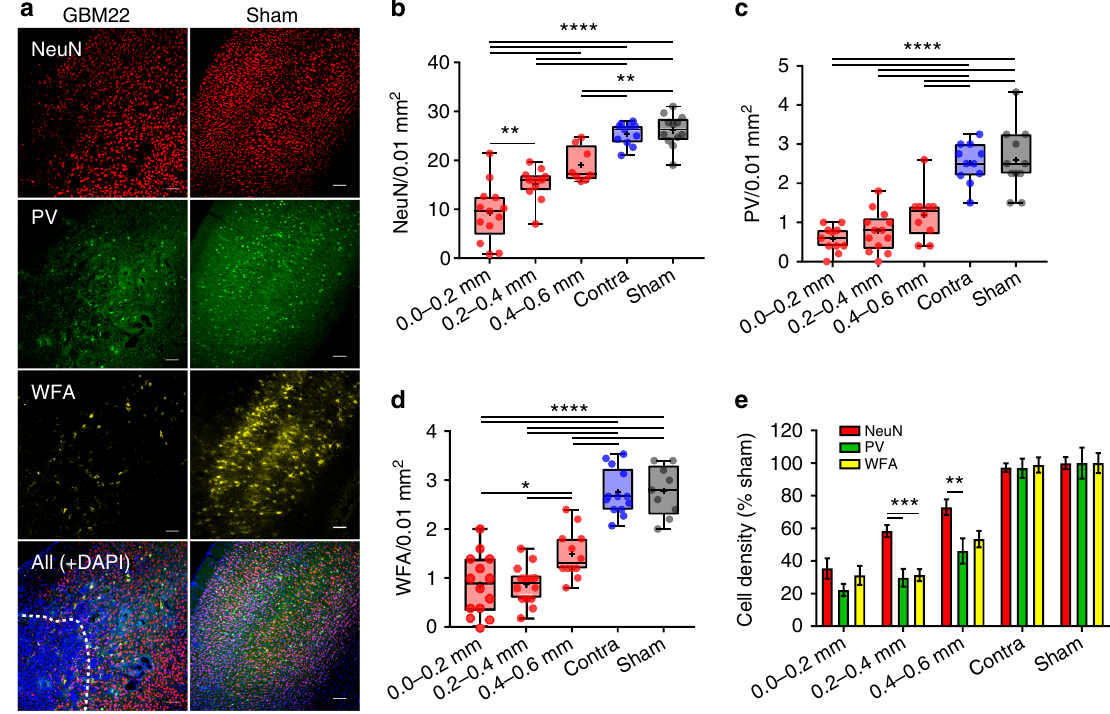
Fig. 1 Glioma-mediated neuronal cell loss with a preferential vulnerability of PV interneurons. a Representative images of NeuN (red), PV (green), and WFA (yellow) labeling, top to bottom, in glioma-injected (left) and sham-injected (right) cortical slices. Glioma mass (bottom left) can be discerned by highly dense DAPI-positive cell nuclei delimited by dashed line. Scale = 100 µ m. b Mean density of NeuN + neurons at 0.0 – 0.2 mm (9.25 ± 1.63), 0.2 – 0.4 mm (15.25 ± 0.94), and 0.4 – 0.6 mm (19.06 ± 1.28) distance from the glioma mass compared to equivalent position in contralateral (25.41 ± 0.68) and sham animals (26.12 ± 0.94). n = 6 mice. c Summary of PV + neuron cell density at 0.0 – 0.2 mm (0.58 ± 0.1), 0.2 – 0.4 mm (0.77 ± 0.14), and 0.4 – 0.6 mm (1.2 ± 0.2) distance from the glioma mass compared to contralateral (2.52 ± 0.15) and sham (2.6 ± 0.25). n = 6 mice. d WFA + PNNs in the PTC at 0.0 – 0.2 mm (0.87 ± 0.16), 0.2 – 0.4 mm (0.87 ± 0.1), and 0.4 – 0.6 mm (1.48 ± 0.14), from glioma mass compared to contralateral (2.75 ± 0.13) and sham (2.78